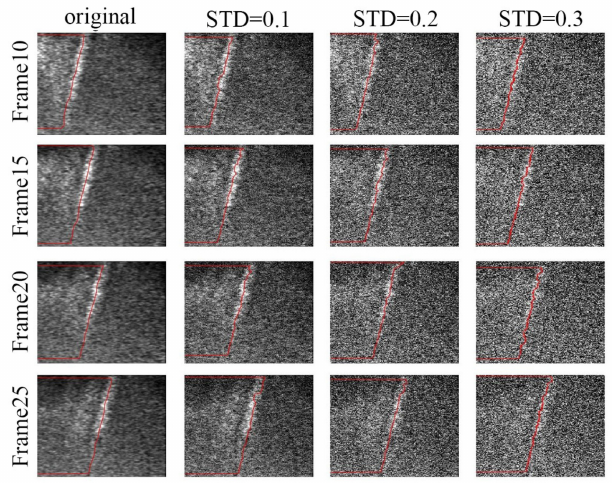
Figure 7. Gaussian noise experiment with equal noise mean.